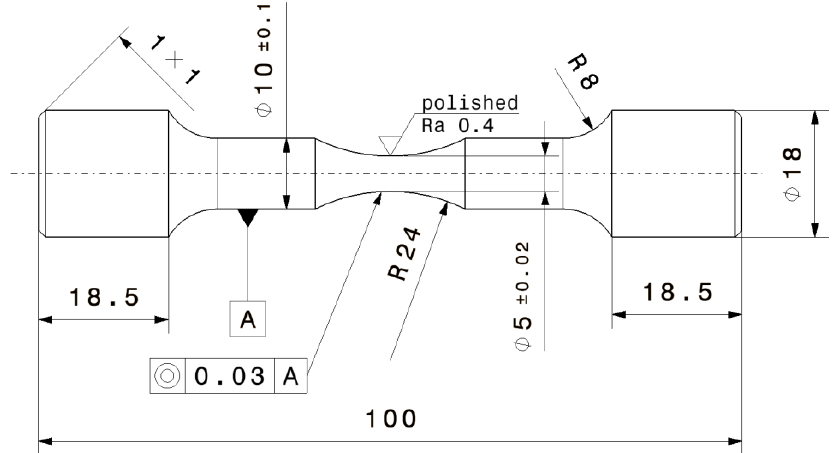
Figure 1. CAD drawing of the specimen geometry for the high cycle fatigue test.